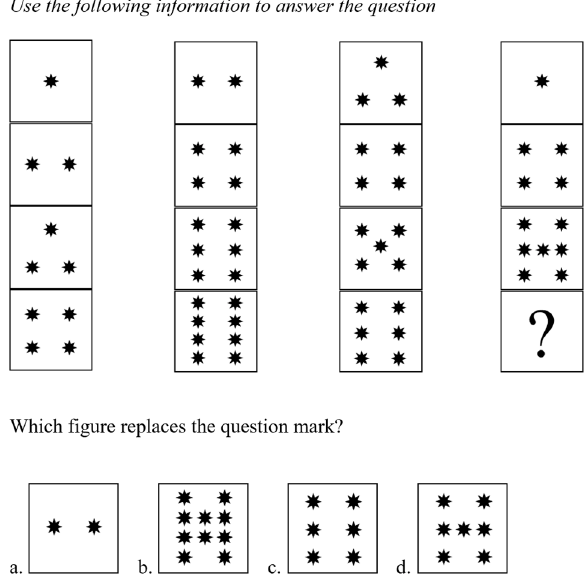
Figure A1. Sample item and answer. Instructions: This test measures your ability to solve problems and reason effectively. Read each question carefully and mark the single best answer. Please note: Option B is the correct answer based on the pattern of the figures.